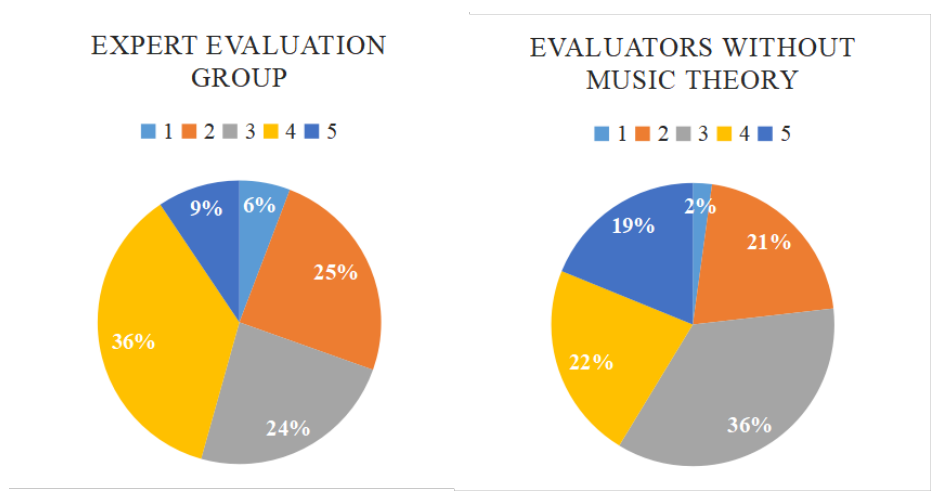
Figure 6. The voting distribution of the two evaluation groups.